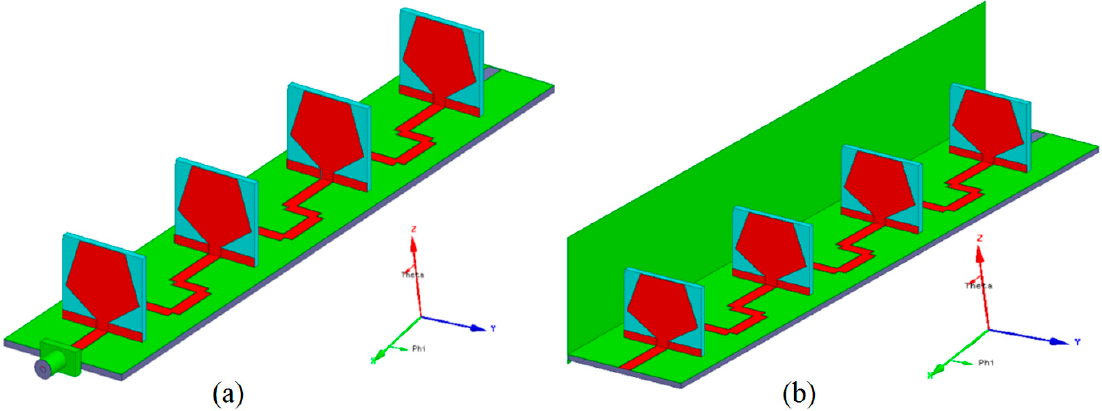
Figure 1. CPW-feed non-planar linear array ( a ) Fan beam antenna array without reflector (perspective view); ( b ) Fan beam antenna array with reflector (perspective view).